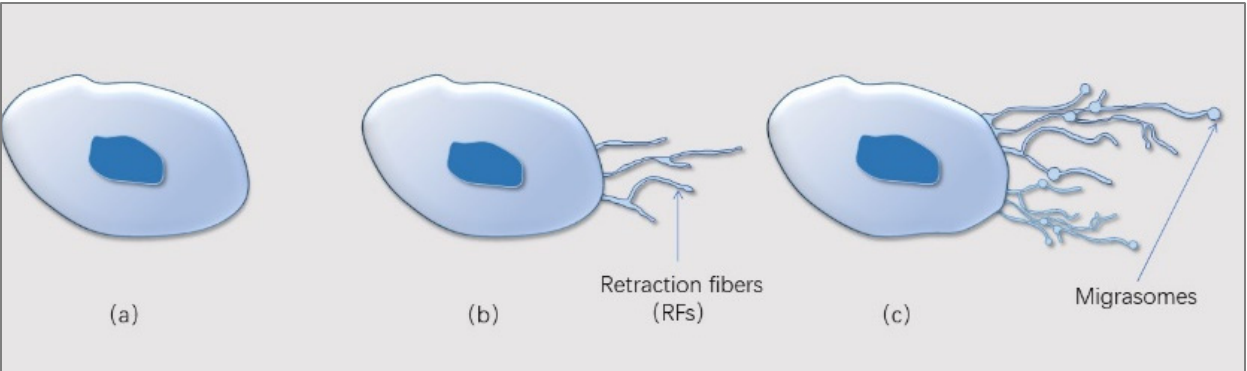
Figure 1. The production process of migrasomes. ( a ) Cells migrate, ( b ) retraction fibers (RFs) are produced at the back of the cells, and ( c ) migrasomes grow at the ends or junctions of the RFs. When RFs break, the migrasomes break away from the cells, and finally break. The contents of the migrasomes are taken up by the surrounding cells. Table 1. Comparison of migrasomes and exosomes.